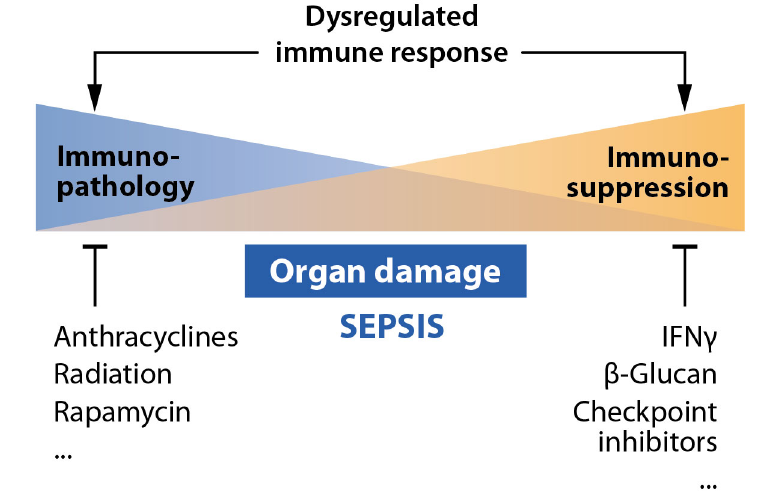
Figure 5. Therapeutic concepts to counter immunopathology and immunosuppression in